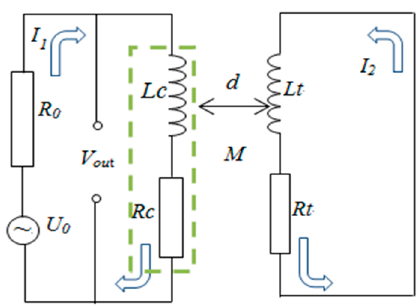
Figure 2. Equivalent circuit of measurement.